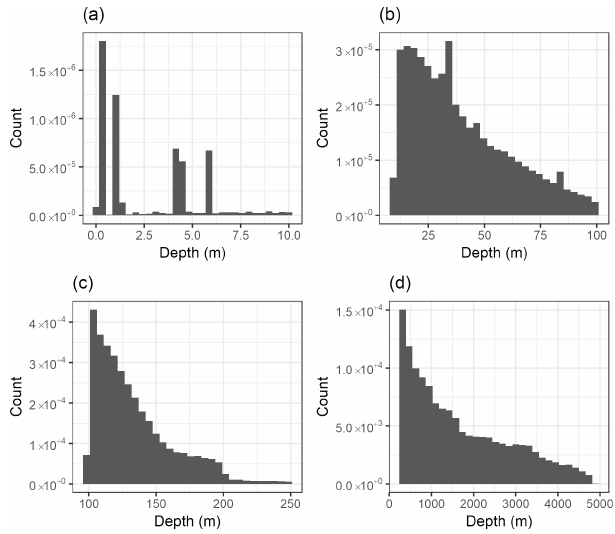
Figure 6. Illustration of data coverage with depth: (a) ≤ 10, (b) ≥ 100, (c) > 100 ≤ 250, (d) > 250m (note the orders of mag- nitude differences in counts).